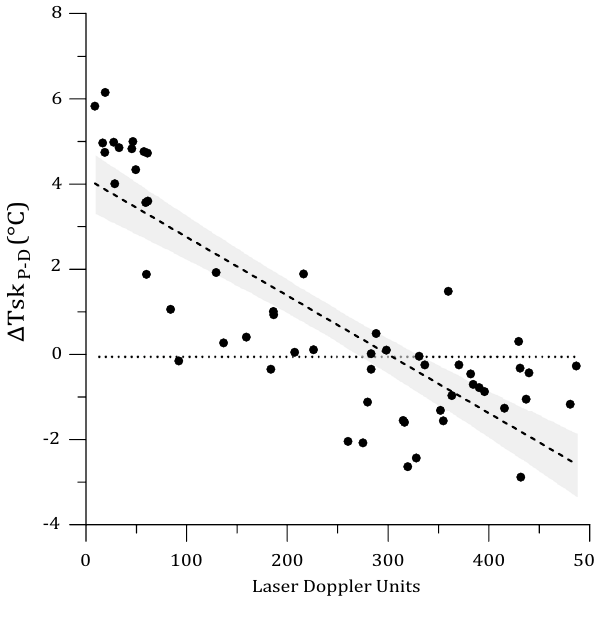
Figure 2. Relationship between ∆TskP-D and LDF measurements, with associated regression line. Data points relate to measurements recorded during the final 2-min in each condition (supine or HUT).